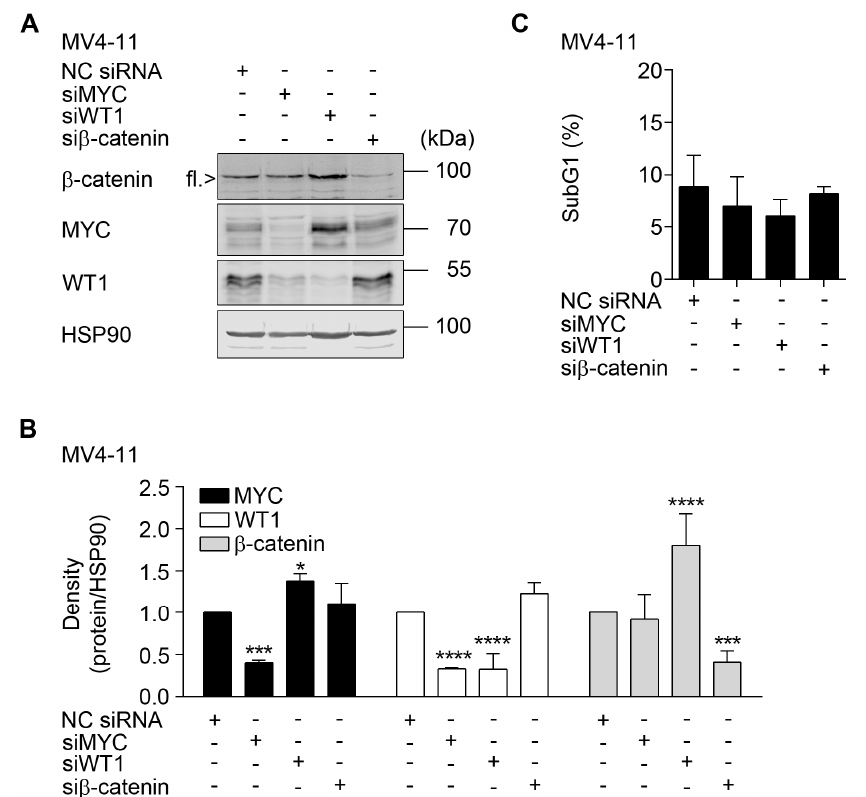
Figure 5. Cross-talk between β -catenin, MYC, and WT1. ( A ) MV4-11 cells were electroporated with 100 pmol of indicated siRNAs and incubated for 48 h (NC siRNA, scrambled irrelevant control siRNA; si, siRNA). Proteins were detected by Western blot, with HSP90 as loading control ( n = 3). ( B ) Densitometry evaluation of data shown in (A) ( n = 3; mean + SD; two-way ANOVA; * p ≤ 0.05; *** p ≤ 0.001; **** p ≤ 0.0001). ( C ) Flow cytometry was done with aliquots of MV4-11 cells with an efficient elimination of β -catenin, MYC, or WT1. Cells were fixed, PI-stained, and assessed for apoptotic DNA fragmentation ( n = 3; two-way ANOVA; not